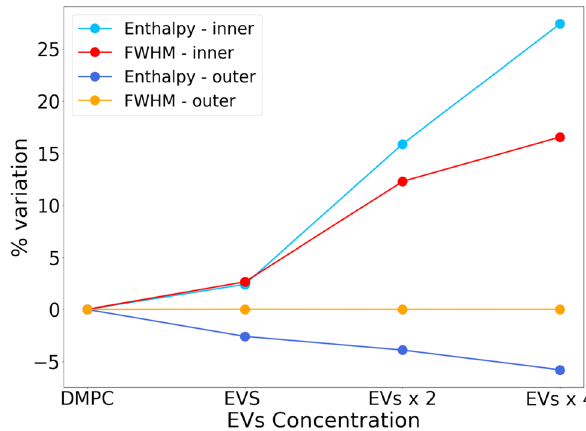
Figure 4: Trend of the percentage change in thermodynamic para - meters at varying EVs addition to DMPC LUVs for the two distin - guished LUVs lea fl